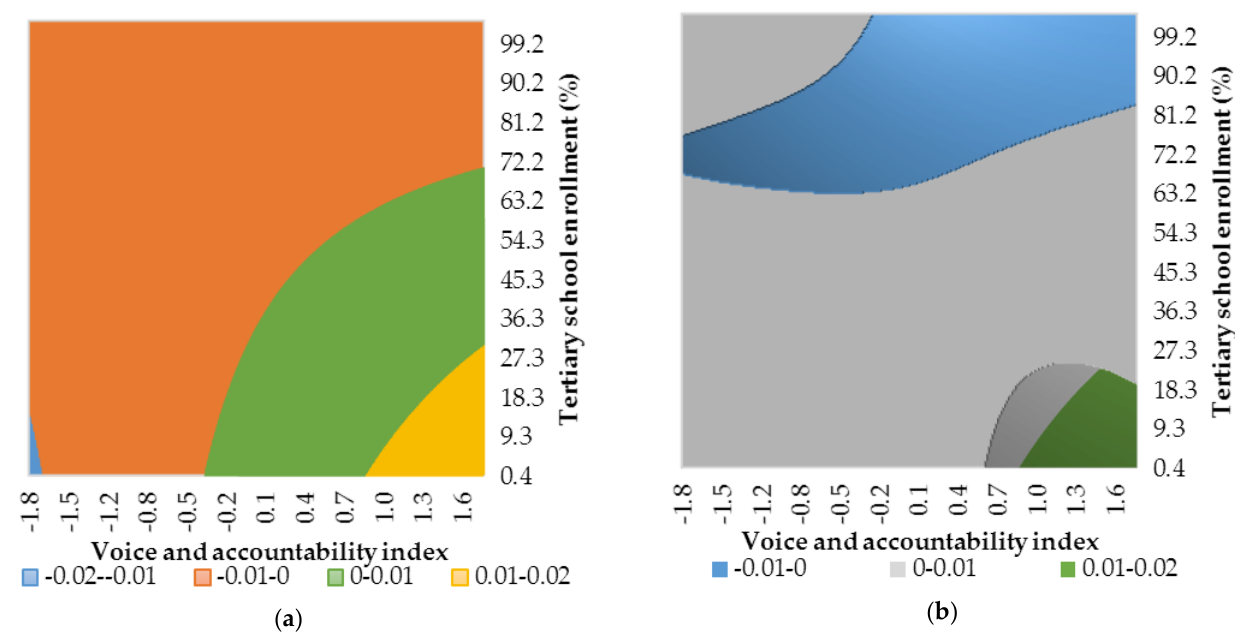
Figure A12. Conditional effect of financialisation on growth based on Est. 12 in Table A2. ( a ) Estimated conditional slope coefficient over the whole range of observed values for institutional quality and development level. ( b ) Estimated statistically significant conditional slope coefficient. Light gray represents a combination of institutional quality and development level for which effect of financialisation on growth is statistically insignificant. Source: authors’ contributions.